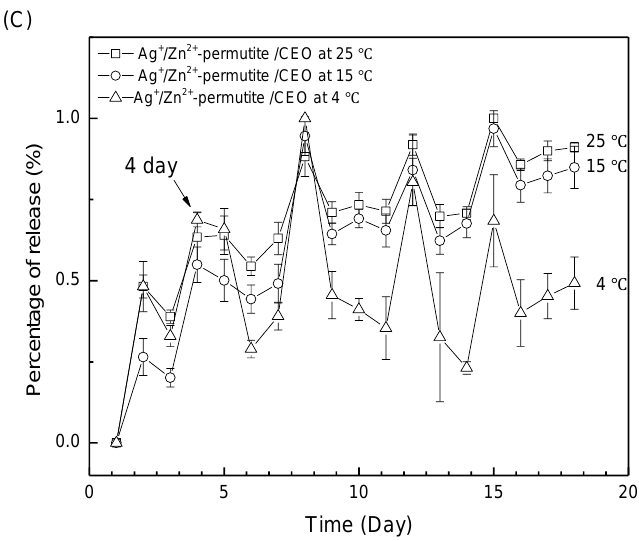
Figure 4. Standard curve ( A ) of cinnamon essential oil ethanol solution; the release profiles of CEO ( B ) and Ag + /Zn 2+ -permutite/CEO ( C ) storage at different temperatures (4 °C, 15 °C, 25 °C).